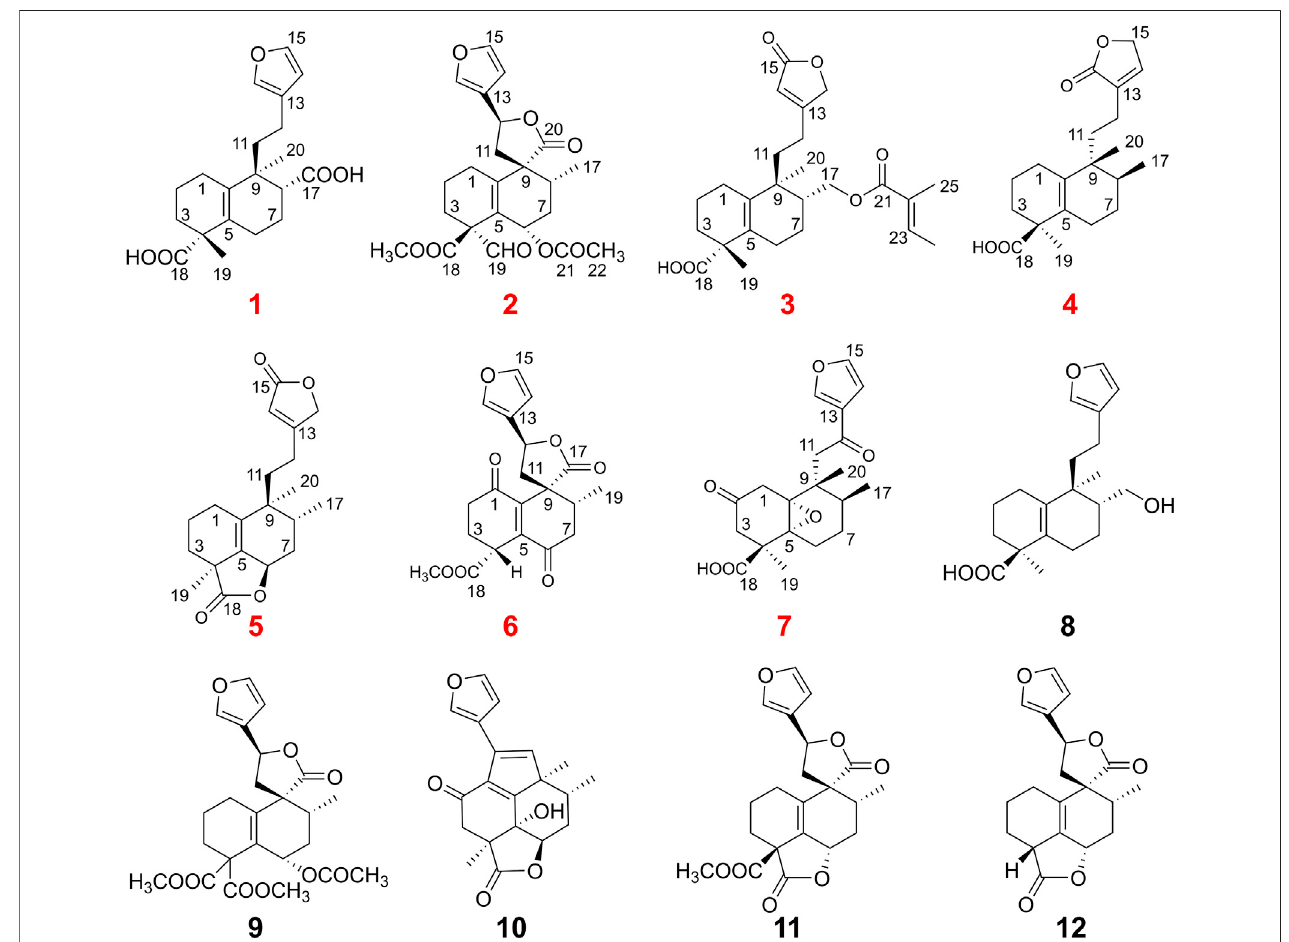
FIGURE 2 | The X-ray ORTEP drawing of compounds 1 , 2 , and 6